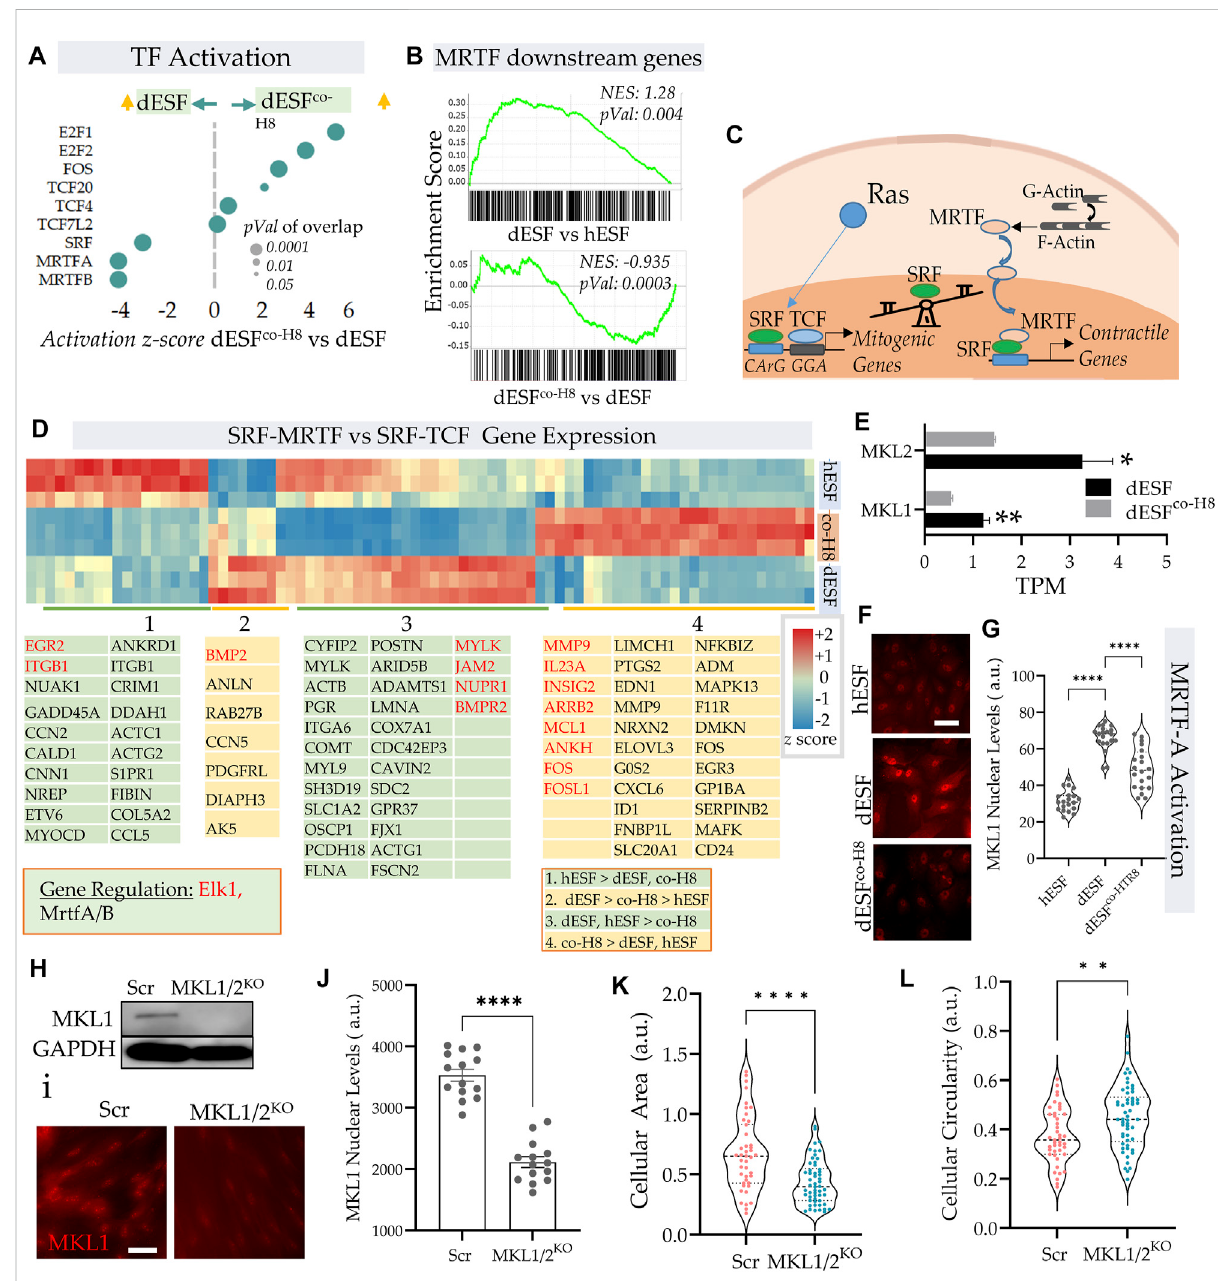
FIGURE 3 EVTs reverse MRTF activation in decidual fi broblasts. (A) Predicted IPA based activation scores of top transcription factors which are reduced in dESFs co-cultured with HTR8 feature MRTF-A, and MRTF-B, as well as SRF. Bubble size re fl ects p -value overlap of genes. (B) Gene set enrichment analysis (GSEA) of SRF-MRTF downstream genes in dESF vs. hESF (top), and dESF co − H8 vs. dESF (bottom); Enrichment score, and p -value shown in inset; leading edge genes for both comparisons shown at the bottom. (C) Schematic showing a balance of contractile and mitogen phenotype maintained by association of MRTA or TCF co-factors with SRF. (D) Heatmap showing z-scores genes activated by SRF in hESF, dESF and dESF co − H8 . Hierarchical clustering by Euclidian distance revealed 4 main clusters that were either upregulated in hESF, dESF, both hESF and dESF, or in co- culture condition. Genes that are downstream of Elk1 activation are coded with red color and MRTFA/B are coded with black color. Color intensity bar shows z score calculated from TPM values. (E) Transcripts per million (TPM) for MKL1 and MKL2 in dESF, and dESF co − H8 ; n = 3 samples. (F) Representative immuno fl uorescence images showing MKL1 (MRTF-A) expression in hESF, dESFs, and dESF co − H8 , with quanti fi cation of fl uorescence levels in the nuclei shown in (G) ; signi fi cance was calculated using Anova followed by Tukey ’ s test; n = 20 for each condition. (H) Immunoblot showing reduced MKL1 abundance in dESFs before, and after silencing of both MKL1 and MKL2 genes (MKL1/2), lower lane shows abundance of GAPDH; also con fi rmed with immuno fl uorescence (I,J) . (K,L) Morphological changes in dESFs in response to MKL1 and MKL2 gene silencing in dESFs, showing single cell area (K) , and cellular circularity (L)